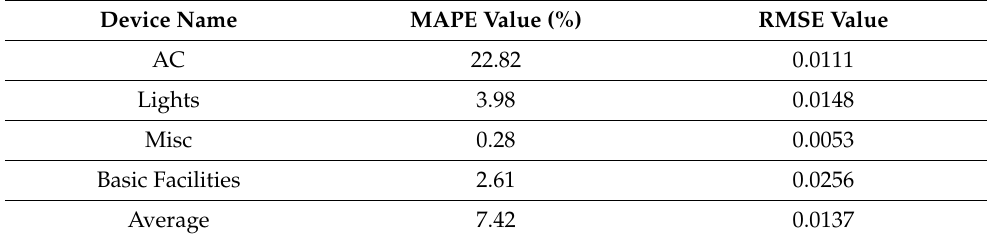
Figure 5. RMSE values for devices using GrAb . Table 4. Prediction accuracy for individual devices in GrAb